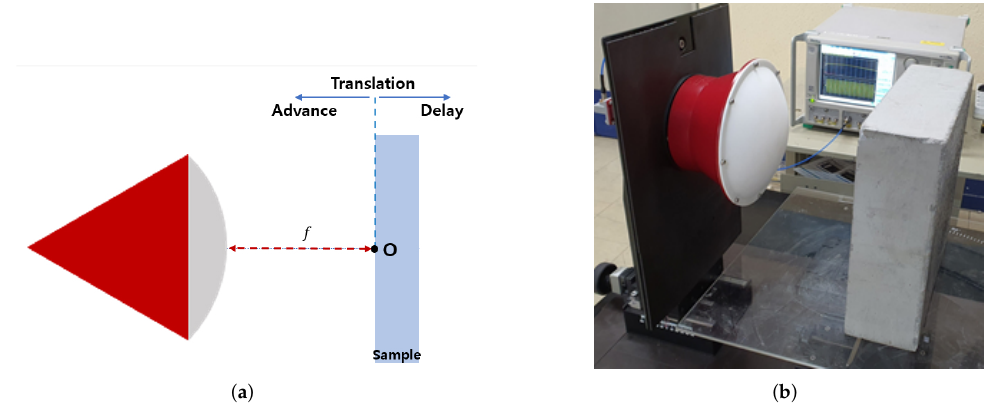
Figure 7. The free-space measurement environment. ( a ) Diagram of the measurement environment. ( b ) Measurement system with concrete sample.